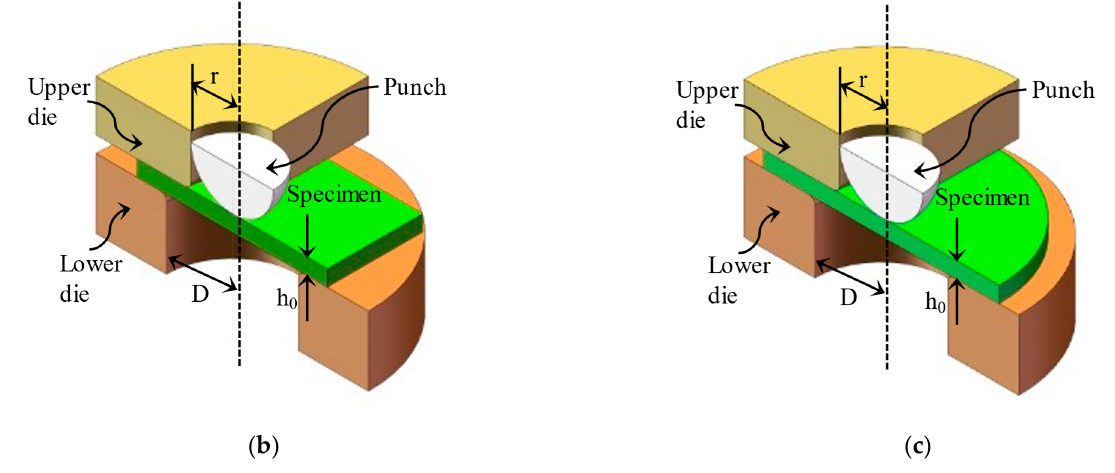
Figure 6. Schematic diagram of FE model of SPT. ( a ) 2D model; ( b ) 3D model with square specimen; ( c ) 3D model with round specimen. Table 4. Geometric parameters of SPT for 2D and 3D models.